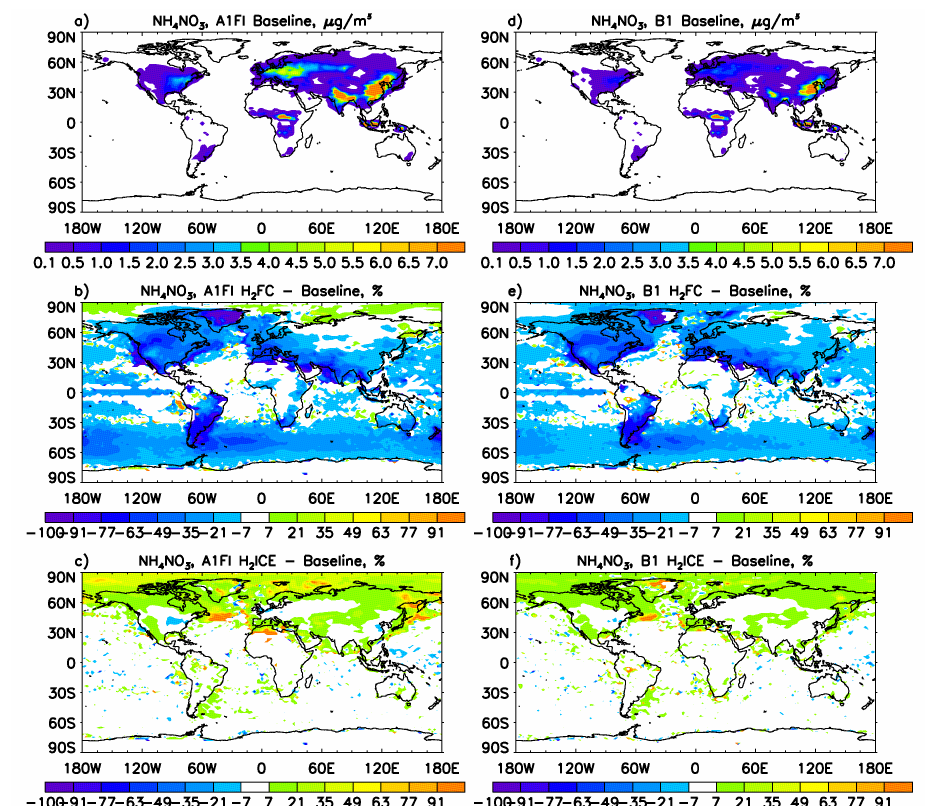
Figure 16. CAM-Chem simulated 2050 annual mean surface NH 4 NO 3 concentrations in the A1FI (a) and B1 (d) baseline scenarios and percent differences for the H 2 fuel cell (H 2 -FC) and H 2 internal combustion engine (H 2 -ICE) scenarios (b, c, e, f) . Note the different scales.